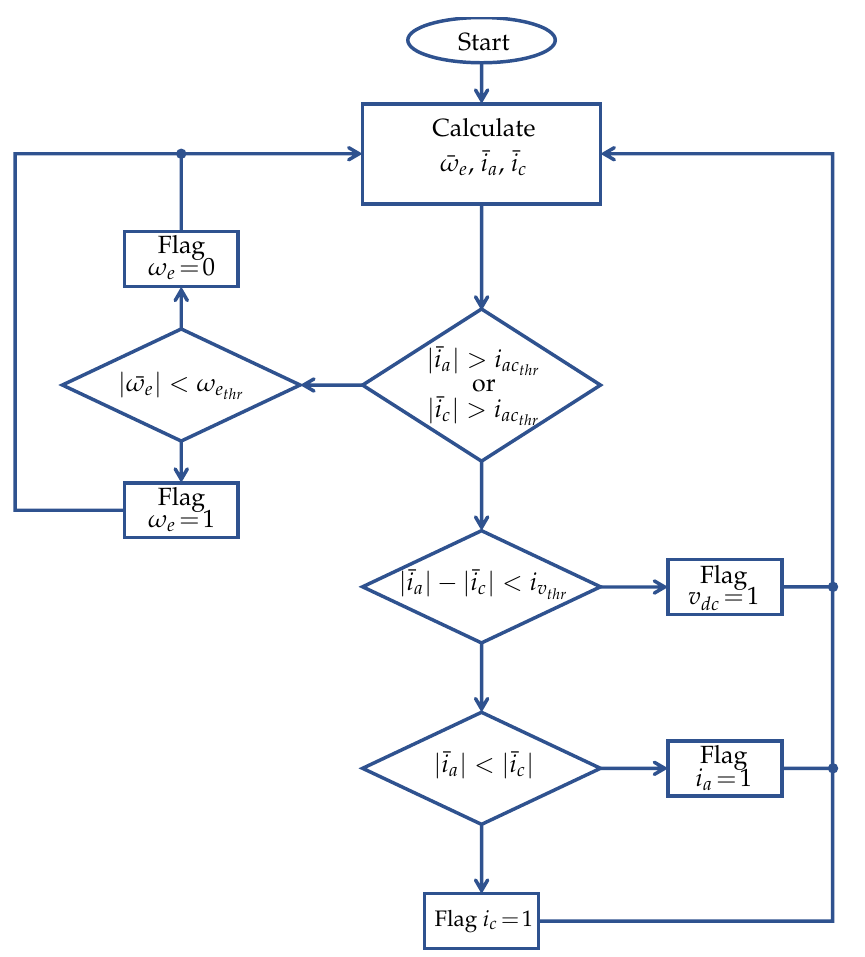
Figure 6. Algorithm to diagnose the sensor faults with